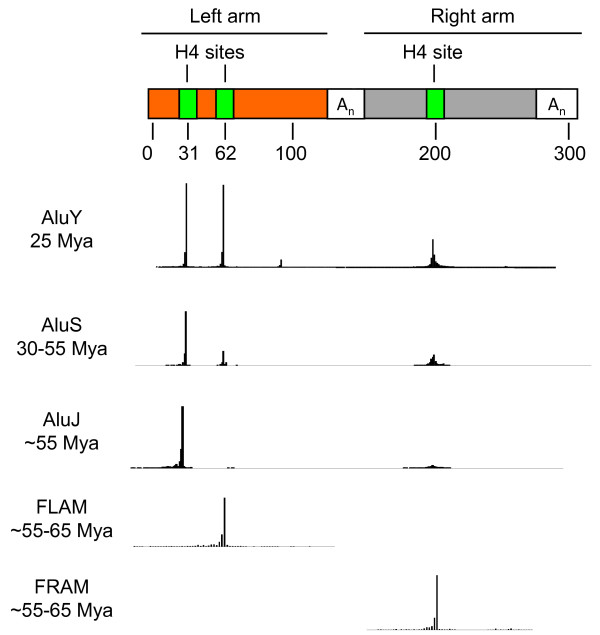
Distribution of HNF4α binding sites in Alu repeats. Frequency histogram showing the position of HNF4α binding sites in AluY, AluS, and AluJ families of SINEs as well as the precursors FLAM and FRAM. The approximate age of the repeats is indicated. The slight variation in peaks at positions 31, 62 and 200 are due to small differences in the length of the Alu repeats.